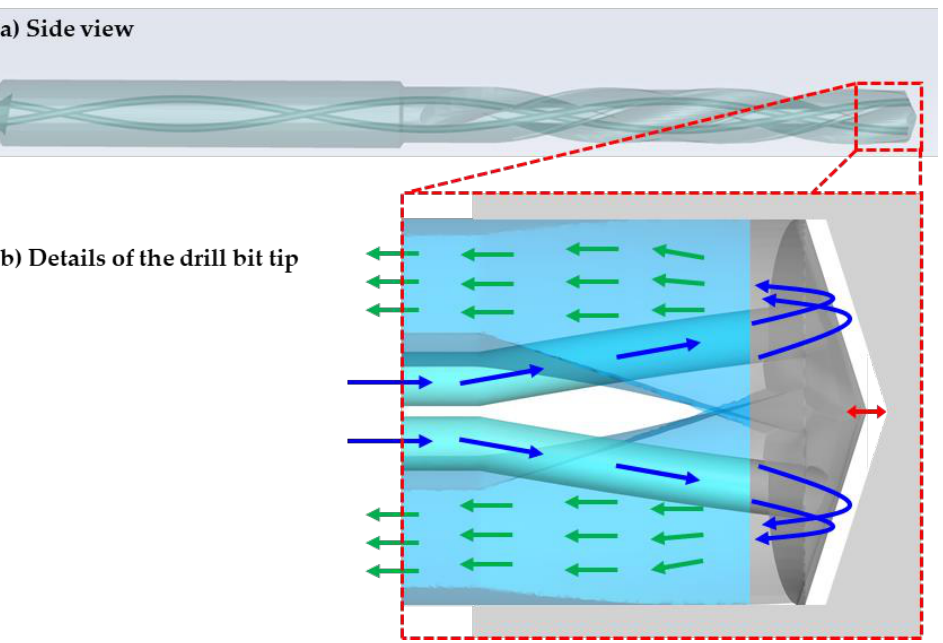
Figure 1. Sketch of the drill bit: ( a ) side-view; the internal helical channel is highlighted; the MWF is transported through the internal channel to the cutting zone ( b ) details of the drill bit tip and flow direction (blue and green arrows) and vibration of the drill bit (red left-right arrow). Dimensions of the numerical domain are presented in Table 1. Table 1. Geometric dimensions of the numerical domain and operating